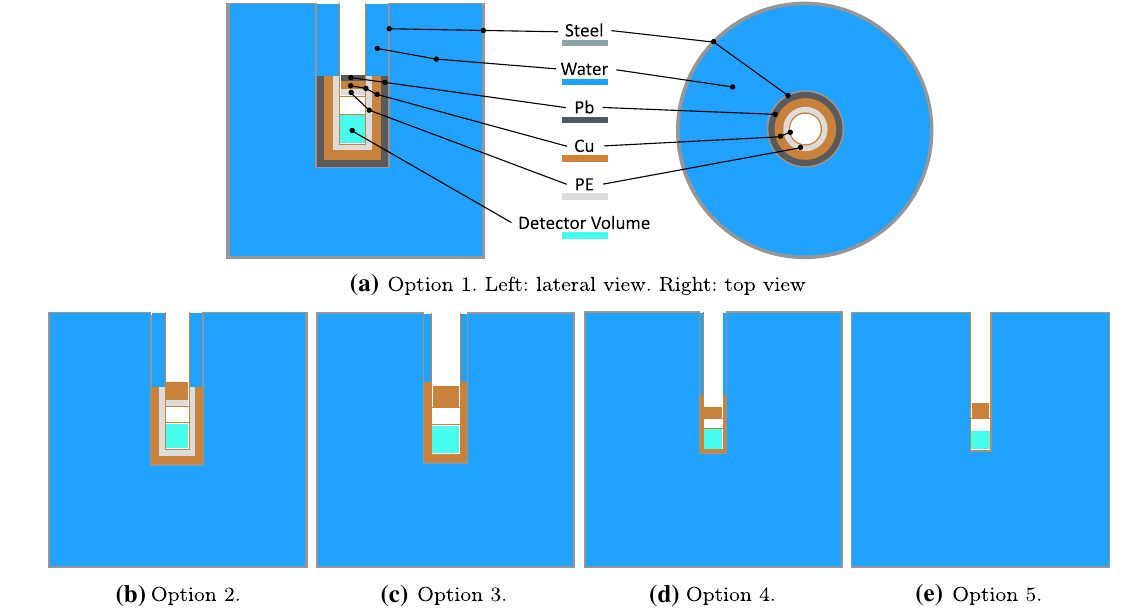
Fig. 4 The five different experimental setups considered for the MC simulation. The Cu cryostat containing the detector volume (cyan box), which will house the NaI detectors, is inserted in a thin stainless steel structure (dry-well) hosting the shielding layers. The detector volume